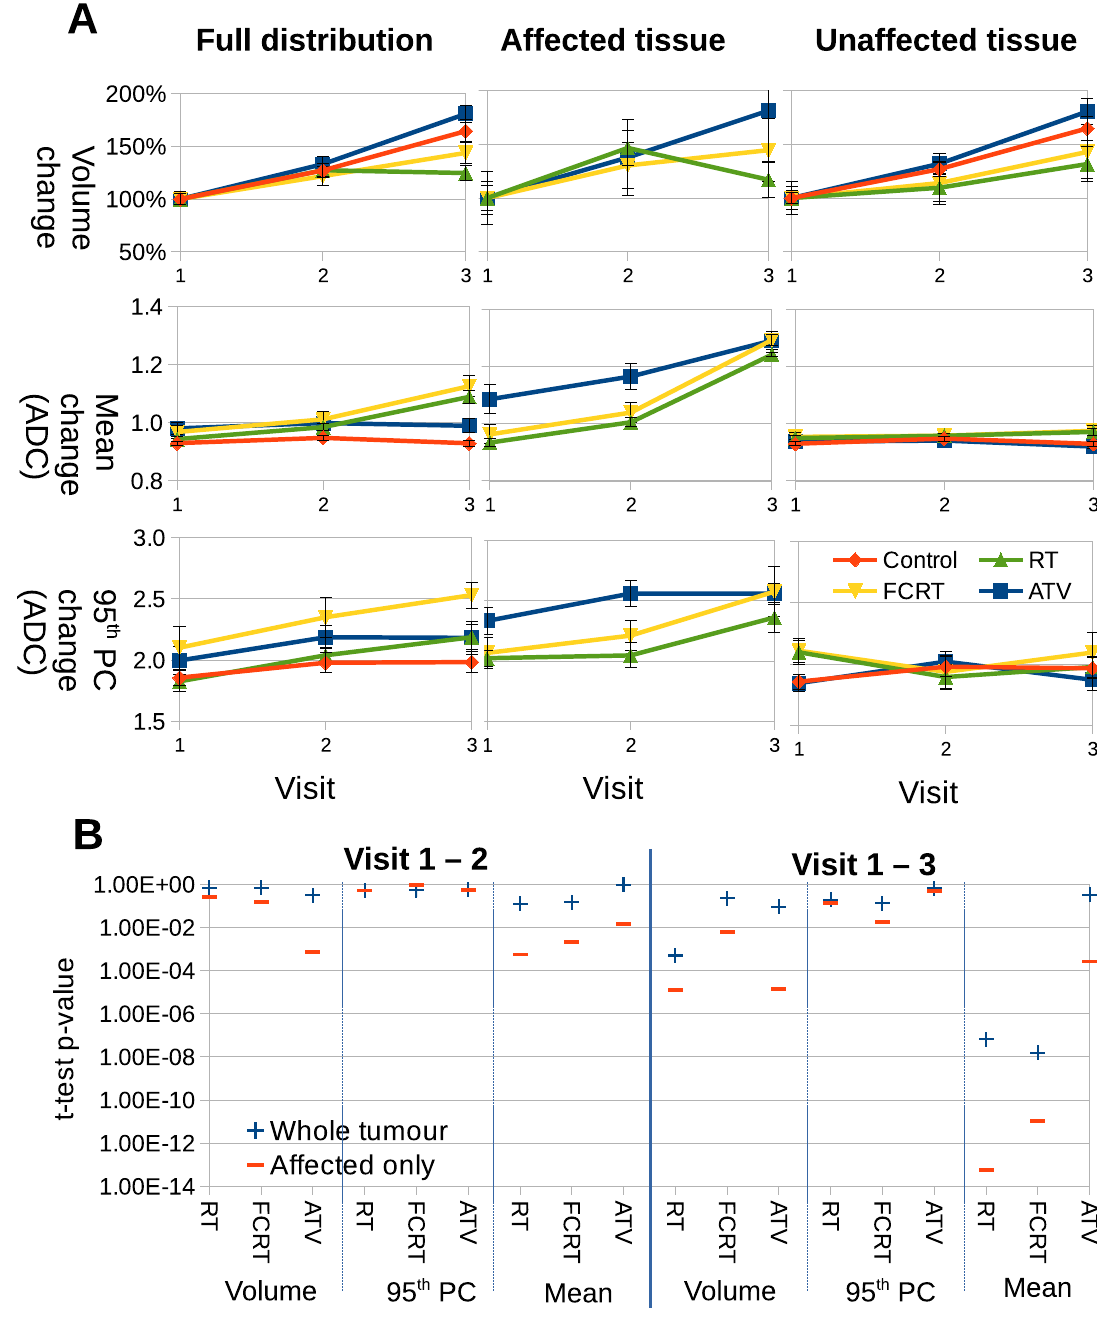
Figure 5. ( A ) Parameters computed using full ADC distributions or sub-distributions as decomposed via LPM. Each curve shows the average behaviour of a different parameter (volume, mean and 95th percentile), as computed from each respective cohort: control, RT, FCRT and ATV. ( B ) p -values achieved via t -tests comparing control to treatments using basic parameters between different time points. From left to right, the columns show parameters for the full distribution (a standard analysis of ADC), from affected regions, and for unaffected